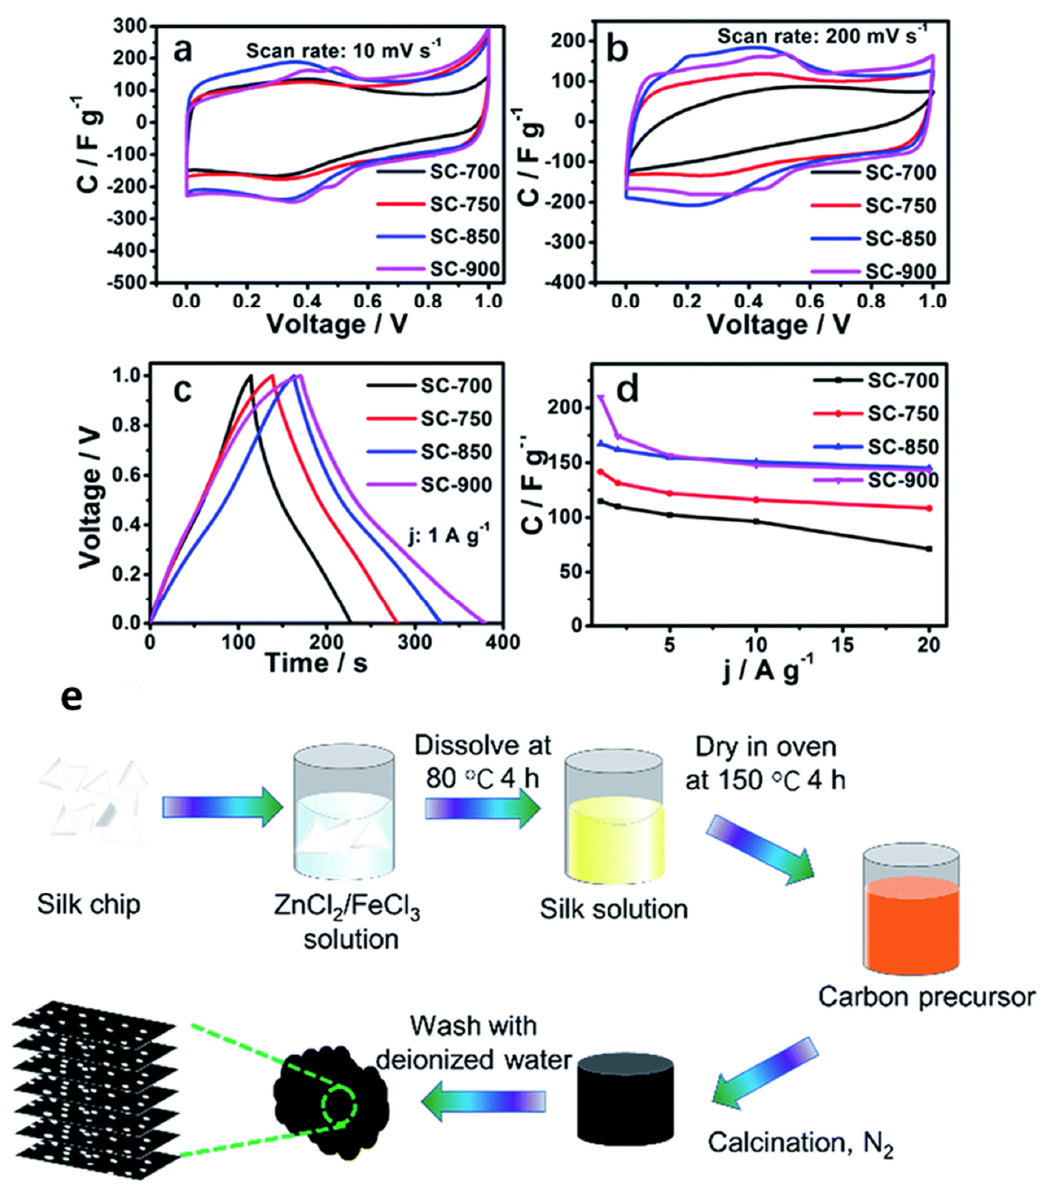
Figure 8. Supercapacitor electrochemical performance evaluation ( a ) CV curves at 10 mV/s. ( b ) CV curves at 200 mV/s. ( c ) GCD curves at 1 A/g. ( d ) Specific capacitances at different current densities. ( e ) Silk synthesis method. Adapted from reference [56]. This article is an open-access article distributed under the terms and conditions of the Creative Commons Attribution (CC BY 3.0)